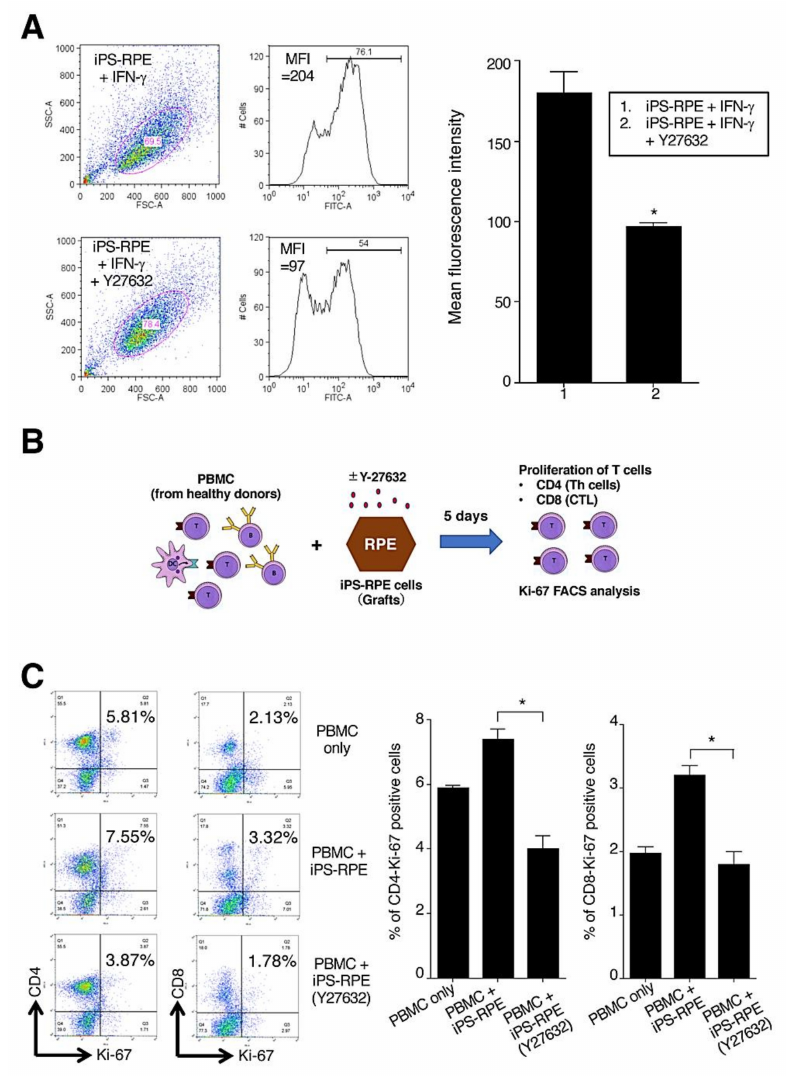
Figure 3. Y-27632-treated iPS-RPE cells have low immunogenicity. ( A ) Expression of HLA-class II molecules on Y-27632-treated iPS-RPE cells (TLHD2 lines). Before the assay, RPE cells were pretreated with recombinant IFN- γ (100 ng/mL) for 48 h. Compared with nontreated cells, the expression of HLA-class II (DR, DQ, DP) on Y-27632-treated iPS-RPE cells was poor according to FACS. The right panel shows that there were significant differences between Y-27632-treated vs. nontreated RPE cells in mean fluorescence intensity (MFI) of the expression of HLA-class II. Data represent the mean ± SEM of three independent experiments. We obtained similar results with other iPS-RPE cell lines (453F2, 454E2 lines). ( B ) Schema of LGIR assay are shown: PBMC from healthy donors were cocultured with graft iPS-RPE cells. Before the assay, RPE cells were pre-cultured with (or without) 10 µ M Y-27632. After coculturing for 5 days, PBMC were harvested for Ki-67 FACS analysis (e.g., proliferation of CD4 + and CD8 + T cells). Th, T helper cells; CTL, cytotoxic T cells. ( C ) Results of the LGIR test for allogeneic T lymphocytes and Y-27632-treated iPS-RPE cells (TLHD2 lines). PBMCs including T lymphocytes were prepared from healthy donors (all HLA mismatched against RPE cells). For nontreated RPE cells in the LGIR test, there was great proliferation of CD4 + /Ki-67 + and CD8 + /Ki-67 + in PBMC as compared with PBMC only. However, there was poor proliferation of proliferative T cells (CD4 and CD8) against Y-27632-treated RPE cells. The right graph shows %CD4 or %CD8-Ki-67-positive cells (i.e., proliferation of T cells) in FACS analysis ( n = 3, three independent experiments). The proliferative response of CD4 + helper T cells or CD8 + cytotoxic T cells to Y-27632- treated RPE cells was significantly reduced compared with Y-27632 nontreated RPE cells. * p < 0.05 between two